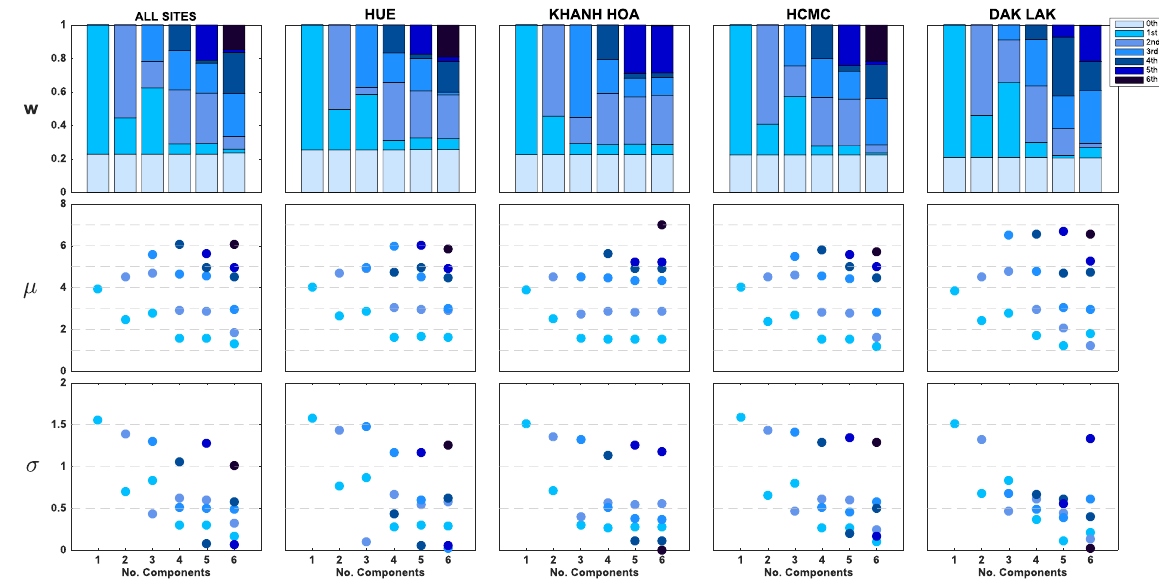
Figure 3. Visualization of model selection process for 2009 H1N1 titer-distribution models from Fig. 2. The y -axes show the fitted values of w i (mixture weights), μ i (means), and σ i (standard deviations). Components’ shades were ranked from lightest to darkest in the order of increasing μ . In the top panel, the “0th component” represents the point mass w 0 placed at 20 for titers below the lower detection limit of 20. Note that in many cases for five or six components, the weights or standard deviation parameters are close to zero; for some cases, two of the inferred mean parameters are very close to each